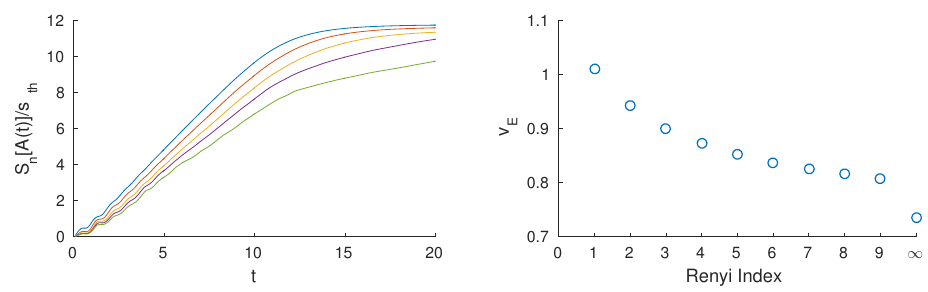
Figure 8 . At left we show the entropy of the (cid:12)rst 12 of 26 spins, starting in the product state j Y + i . The di(cid:11)erent curves represent the von Neumann entropy (top), and the 2,4,8, 1 R(cid:19)enyi entropies. At right we indicate (cid:12)ts to the initial slope.